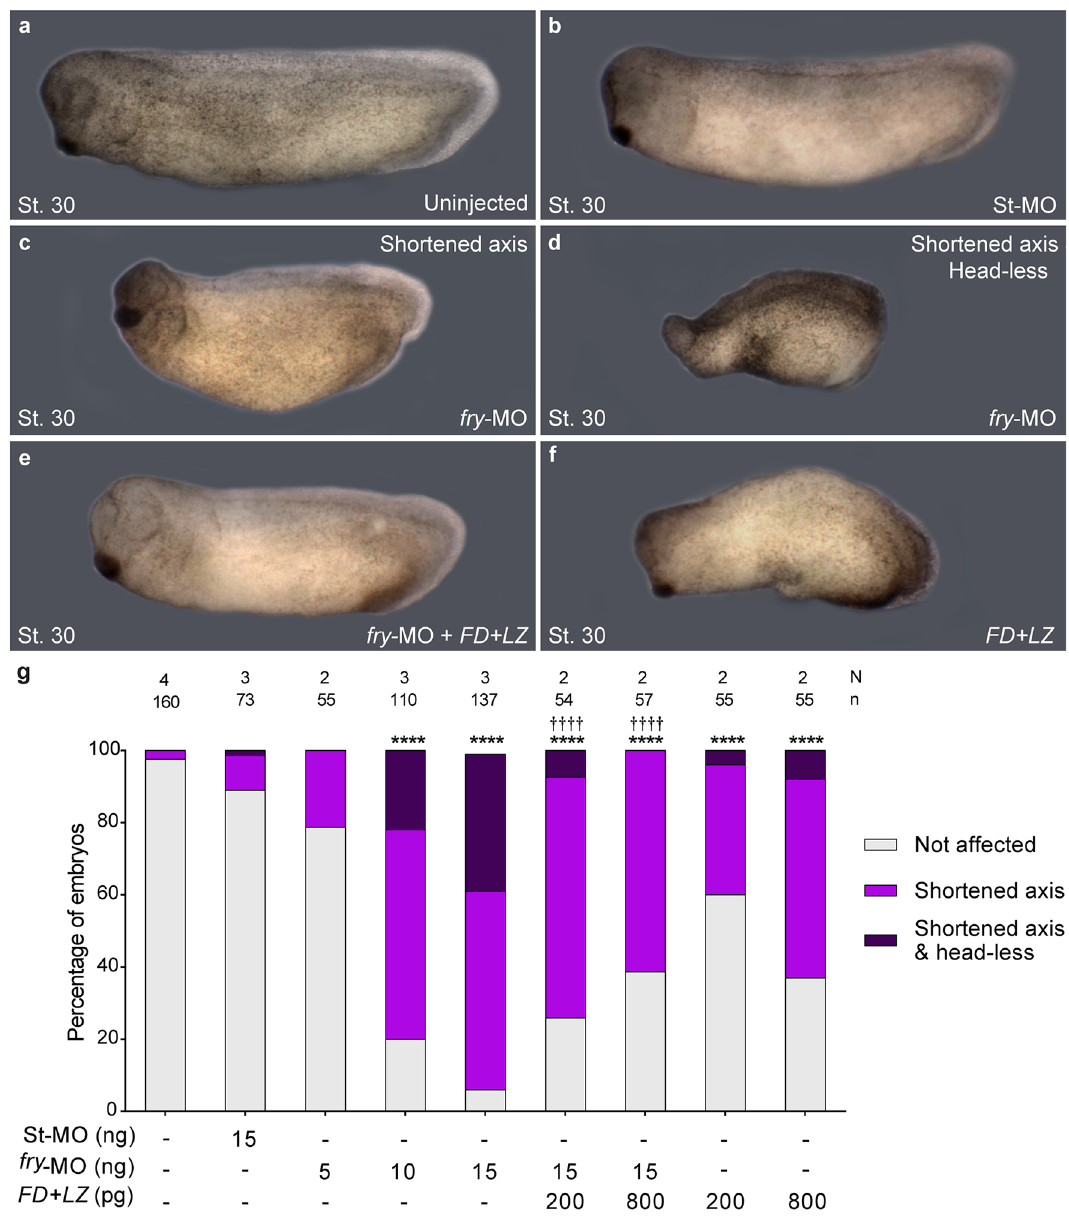
Figure 1. Fry loss-of-function and rescue experiments. 4-cell stage Xenopus embryos were injected into both dorsal blastomeres as indicated and fixed at stage 30 (St. 30). ( a ) Uninjected embryo. ( b ) Standard Control morpholino (St-MO) (15 ng) injected embryo. ( c,d ) fry -MO (15 ng) injected embryos exhibiting “Shortened axis” or “Shortened axis & Head-less” phenotypes, respectively. ( e ) Rescue experiment; fry -MO (15 ng) + FD + LZ mRNA (800 pg) co-injected embryo. ( f ) FD + LZ mRNA (800 pg) injected embryo. Representative embryos are shown. ( g ) Quantitation of the percentage of embryos showing the different phenotypes: “Not affected”, “Shortened axis” or “Shortened axis & Head-less”. Embryos were scored as “Shortened axis” when presented < 80% of the body length relative to the average length of control embryos. N: number of independent experiments, n: number of embryos. Data in graph is presented as mean. Statistical significance was evaluated using Chi -square test (****, †††† p < 0.0001). * represents the comparison to the uninjected group and † represents the comparison to the fry -MO injected and a head-less phenotype. Taken together, these findings indicate that normal Fry function is required for anterior–posterior axis development (Fig. 1f,g). Fry regulates dorsal organizer formation and gastrulation movements. Anterior–posterior axis development is the result of early establishment of mesodermal cell fates and morphogenetic movements that contribute to cell rearrangements during gastrulation 1,3,29 . As Fry has roles in mesoderm development 27,28 and